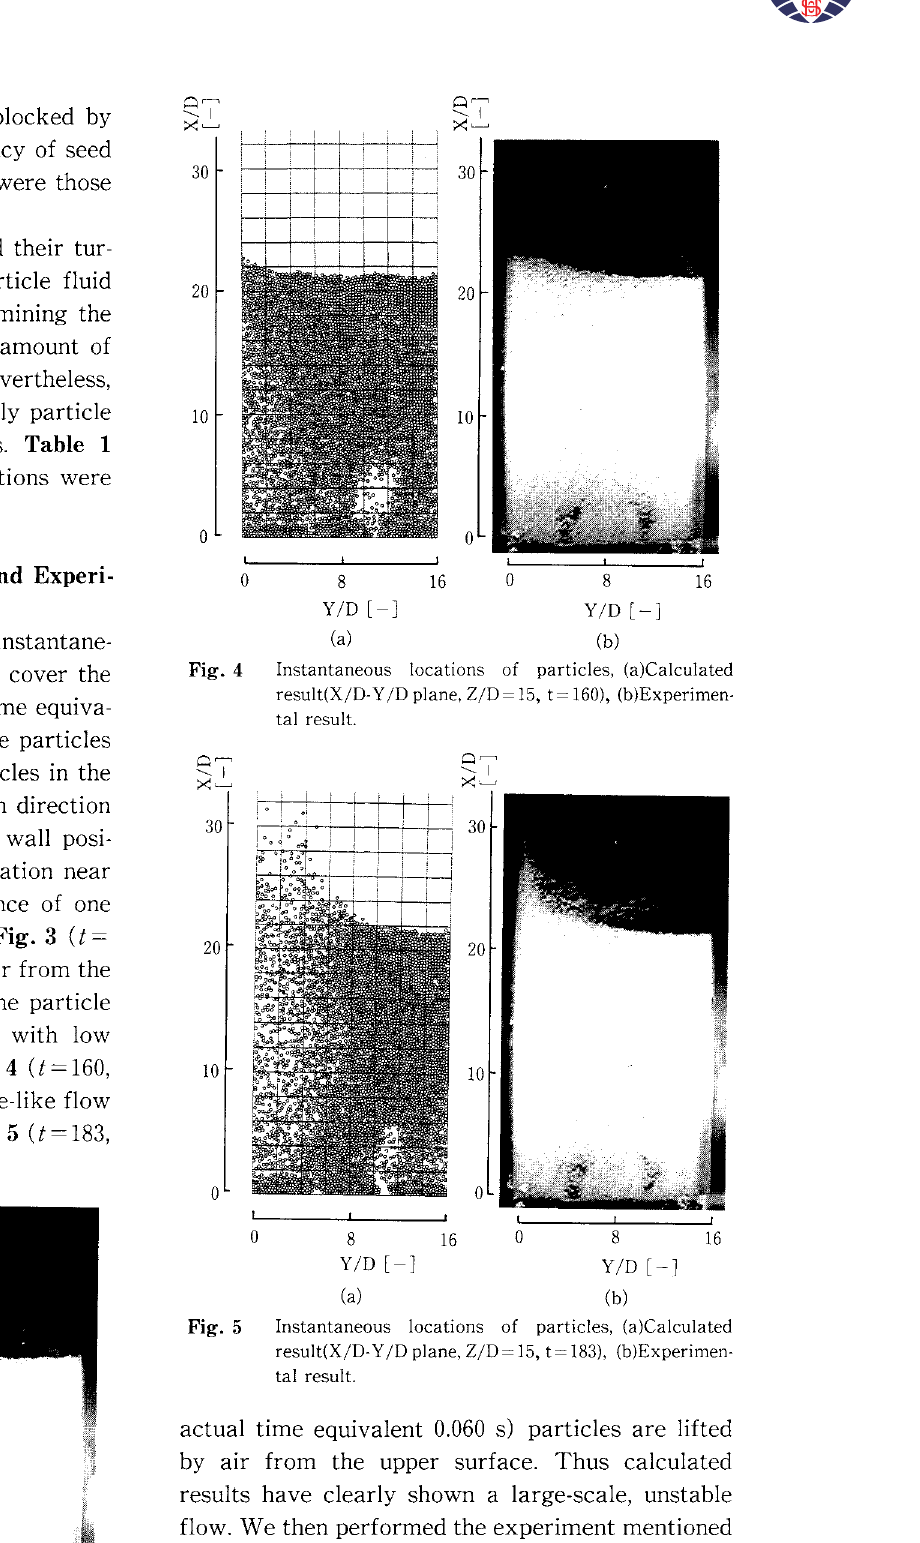
Fig. 5 Instantaneous locations of particles, (a)Calculated result(X/D-Y /D plane, Z/D= 15, t= 183), (b)Experimen tal